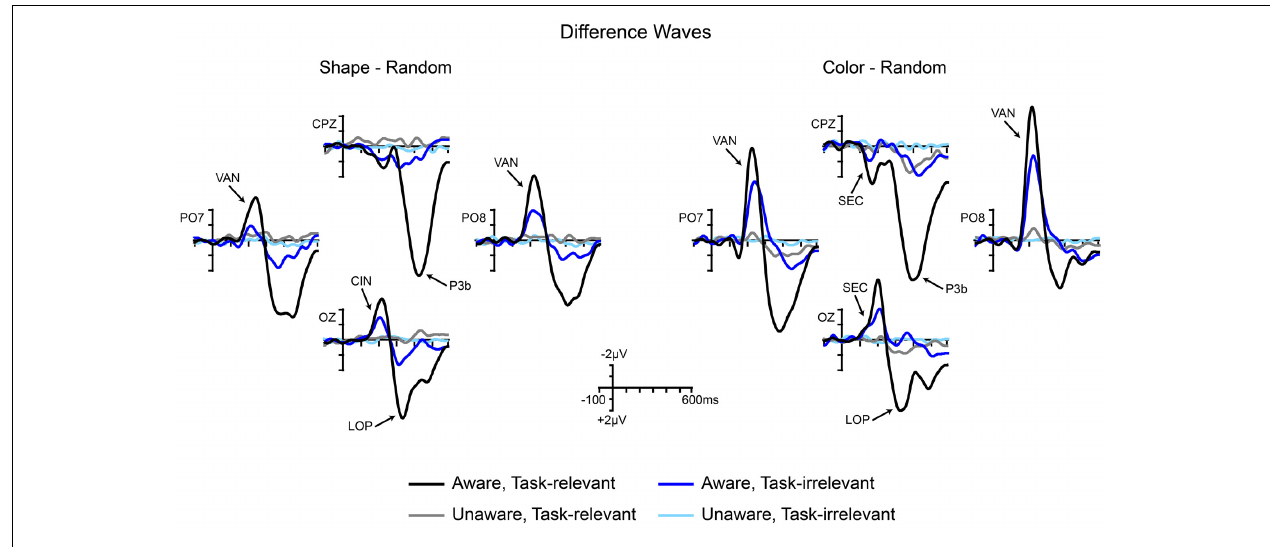
FIGURE 7 | Grand-averaged difference waves for shape stimuli (square minus random) and color stimuli (4-red-lines minus random) across the four conditions of interest. Components are labeled at representative